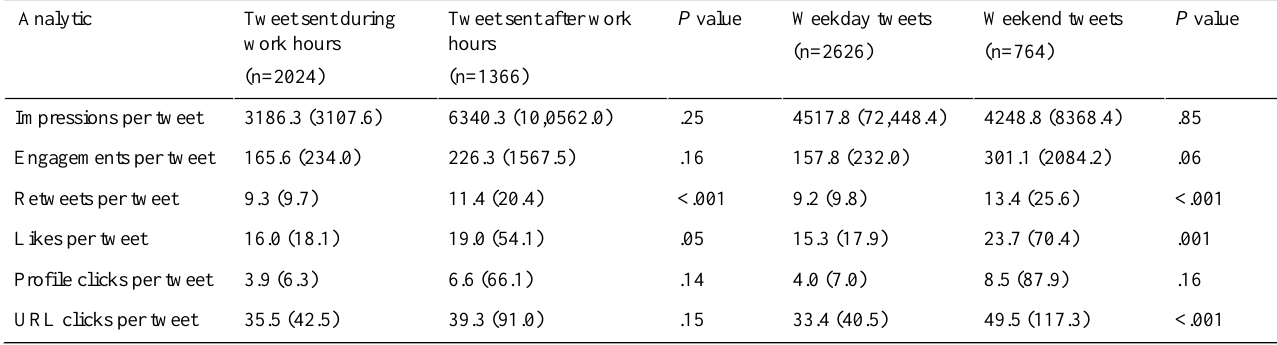
Table 3. Twitter analytics, mean (SD), as a function of time and